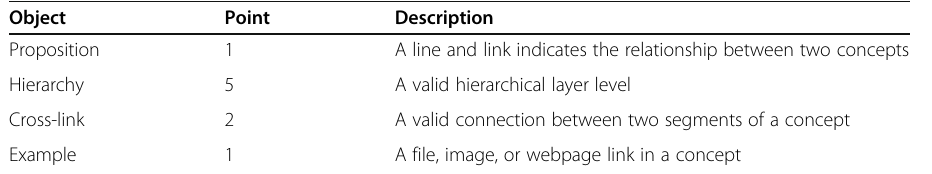
Table 1 Criteria for concept map scoring Object Point